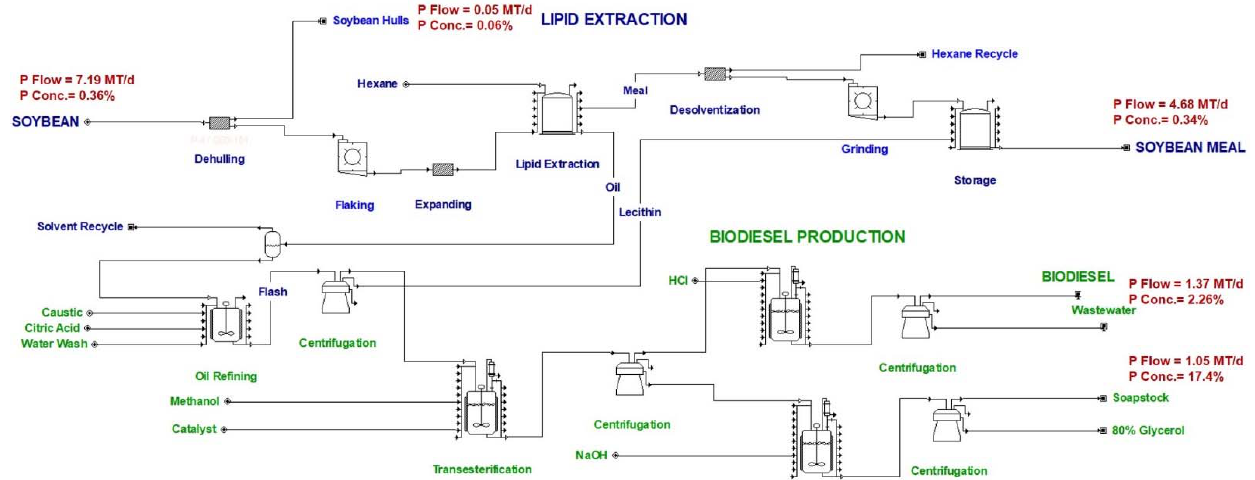
Figure 1. Schematic representation and P flows in the conventional soybean biodiesel (CSB) process. In the receiving and preprocessing section, soybeans were received, cleaned (0.3% soybean impurities), and dehulled prior to oil recovery. Soybean hulls (7% of a soybean) were sold as a coproduct. The dehulled soybeans were conditioned, flaked, and expanded to improve efficiency of the oil extraction process.